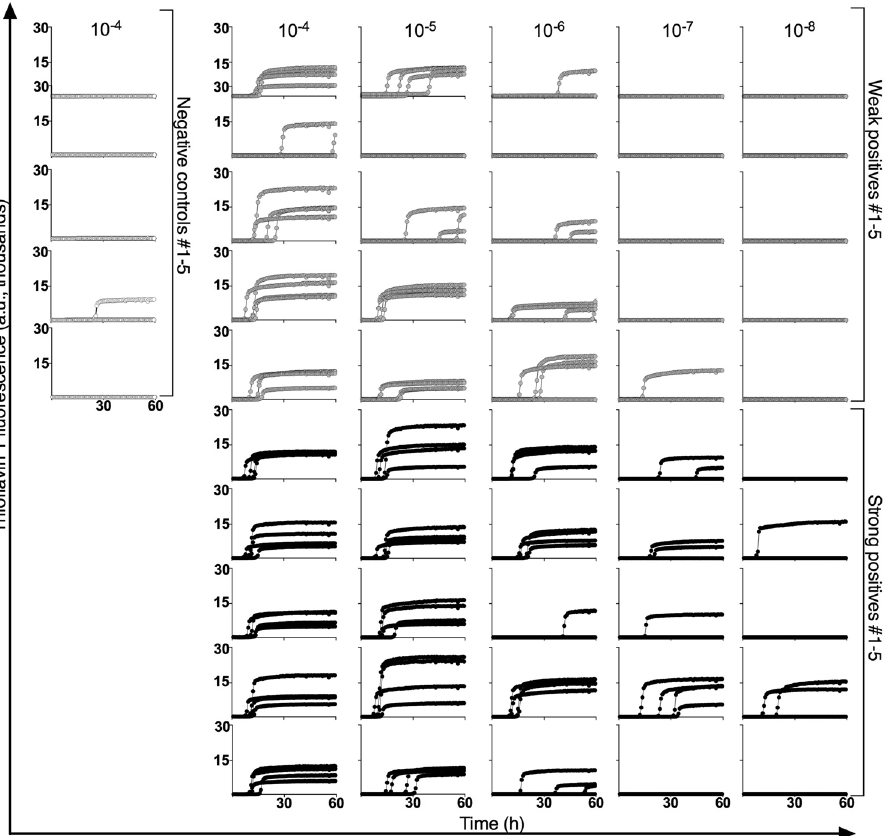
Figure 1. RT-QuIC reactions seeded with RLN homogenates from deer with RLNs that gave either negative, relatively weak, or strong ELISA readings as described in the main text. Replicate aliquots (n = 4) of the designated dilution of each homogenate were independently assayed in microplate wells with the thioflavin T fluorescence indicated in arbitrary relative units (a.u.) as a function of reaction time. Reactions seeded with 10 –4 RLN tissue dilutions (w/v) from negative control deer (n = 5) or the designated dilutions from weak ELISA- positive (n = 5) and strong ELISA-positive deer (n =